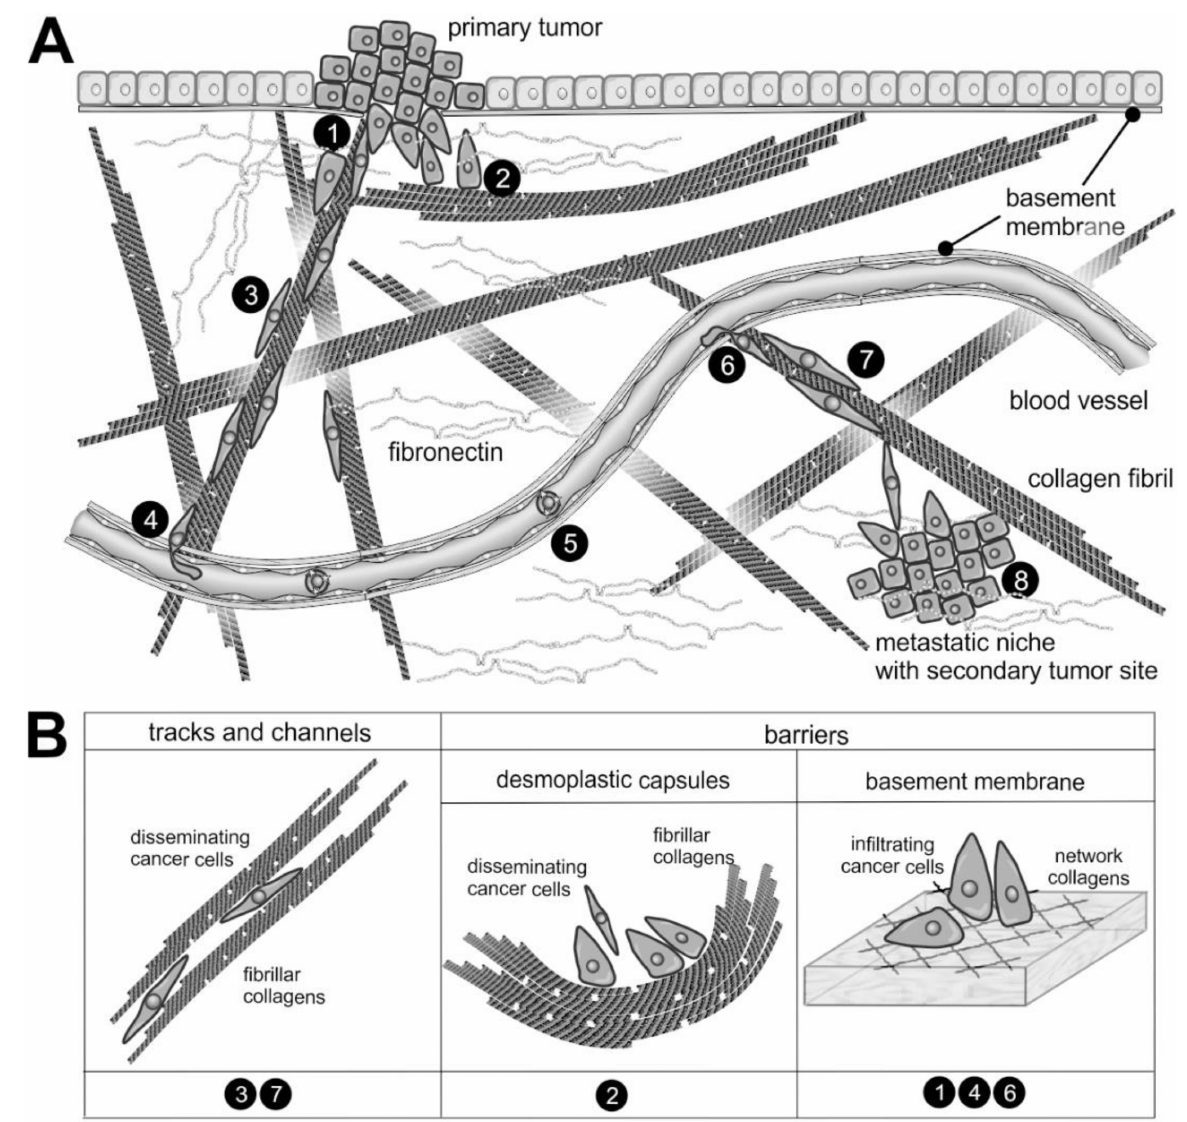
Figure 2. The supramolecular structure of collagen as a substrate or impediment of cancer cell dissemination: ( A ) The metastatic cascade of malignant carcinoma cells includes the penetration of the epithelial basement membrane ( (cid:202) ); Solid tumors within the stroma tissue are often surrounded by a desmoplastic collagen capsule, which impedes cancer cell migration ( (cid:203) ); Through the interstitial stroma, cancer cells utilize collagen-rich fibrils to quickly reach a nearby blood vessel ( (cid:204) ); There, they intravasate through the endothelial basement membrane ( (cid:205) ); When blood-borne, they float with the blood stream, mostly sheltered by platelets ( (cid:206) ); To extravasate, they attach to the vessel wall of a distant organ and again breach the endothelial basement membrane ( (cid:207) ); Moving quickly along collagen-rich fibrils ( (cid:208) ), they reach the metastatic niche ( (cid:209) ), where they grow into a metastasis. ( B ) The different dissemination-supporting and impeding functions of the collagen suprastructures are highlighted for the different steps of the metastatic cascade. The cancer cells experience, particularly by integrins, the ECM as dissemination-supporting tracks and channels, especially if migration and fibrils point into the same direction and if the fibril network is not too dense. In contrast, the dense array of collagen fibrils in desmoplastic capsules and of network-forming collagens within the basement membrane impedes cancer cell progression and requires the use matrix-metalloproteinases. Moreover, the orientation of collagen fibrils within the desmoplastic capsule is mostly perpendicular to the direction of dissemination